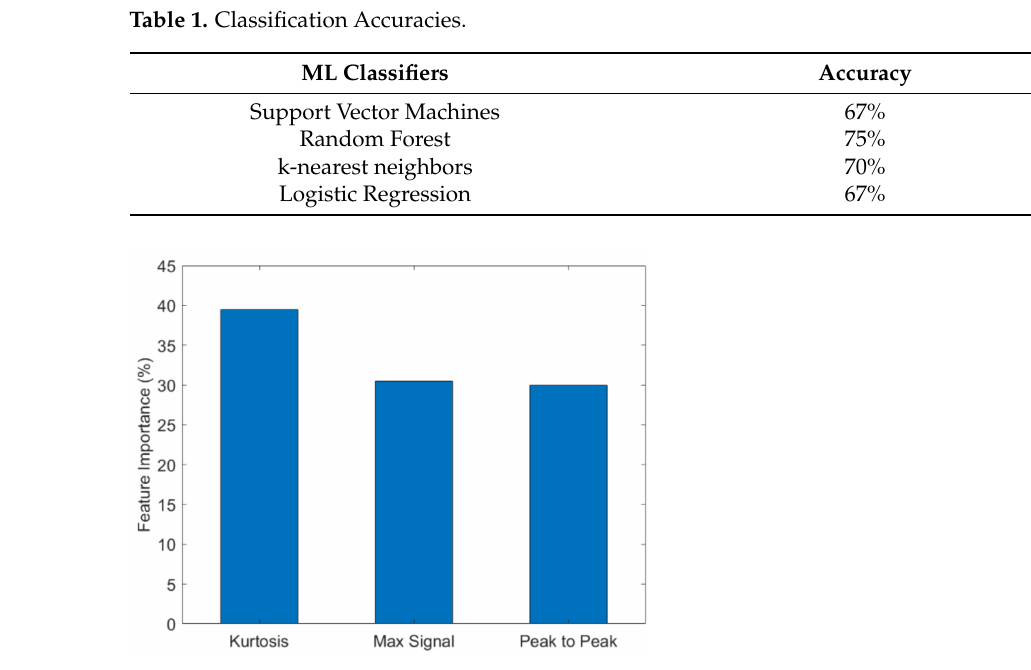
Figure 9. Feature importance based on Random Forest